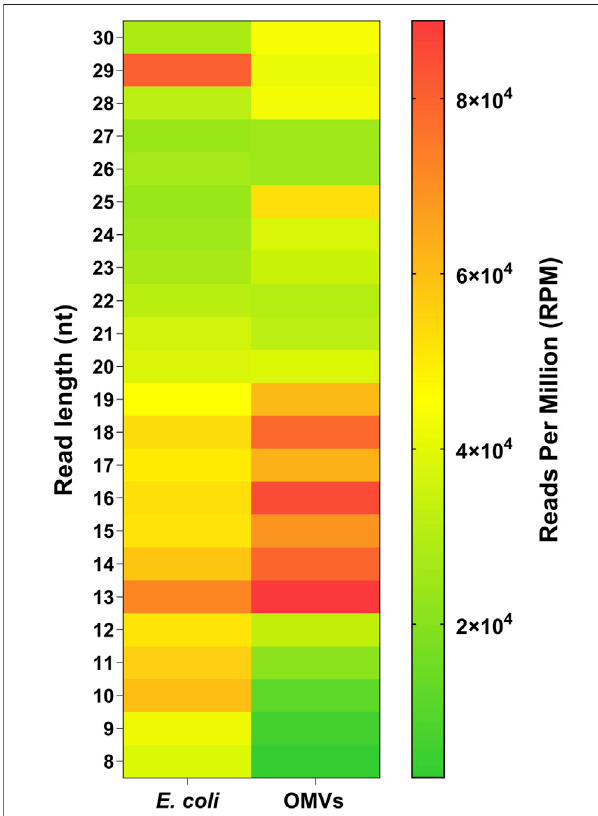
FIGURE 5 | Selective loading of RNA in OMVs. Heatmap showing RNA distributionbetween E.coli andOMVsinrelationtosequencelength(8 – 30 nt). The total reads counts were normalized in reads per millions (RPM). Puri fi ed OMVs were obtained with the Exobacteria kit (For details, see Materials and Methods ).